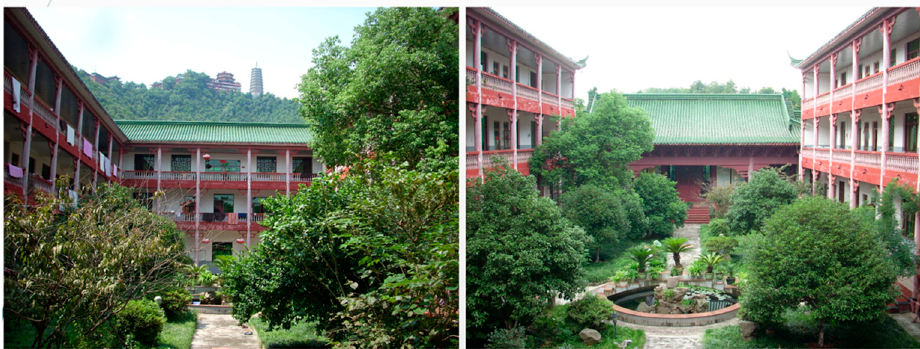
Figure 1. The teaching building of the Jiangxi Dajinshan Buddhist Academy for Nuns.